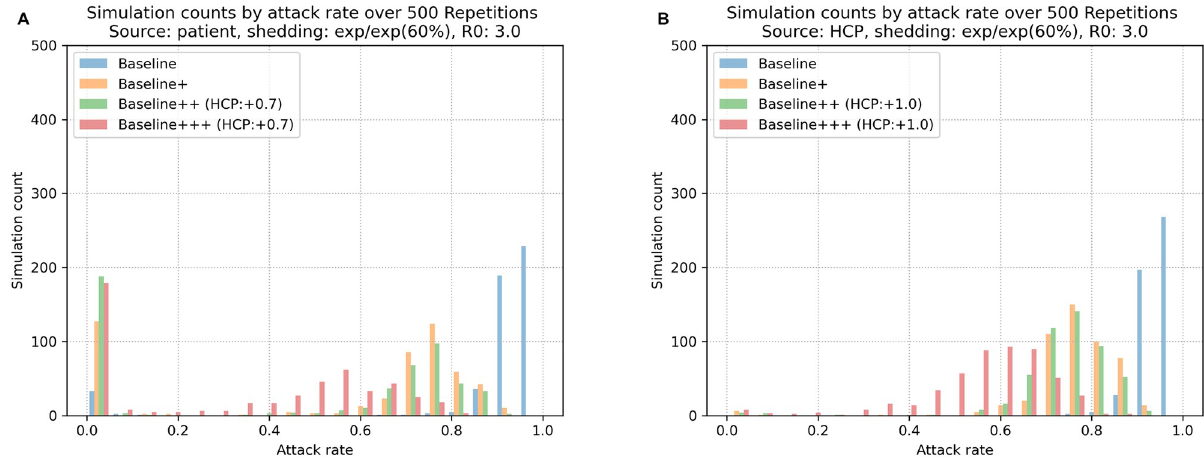
Fig 7. Frequency of replicates as a function of attack rates for different NPIs: (A) Scenario 1 and (B) Scenario 2. Each histogram displays the number of replicates (y axis; out of 500) with the specified overall attack rate. In Scenario 1, two peaks are commonly observed for each histogram; one where no transmission events occur (the infection is immediately quashed) and one indicating the fuller extent of an eventual outbreak. When no intervention is imposed (Baseline), only 31 simulations (6.2%) have no transmission events, while 83.6% (418) resulted in attack rates larger than 90%. In contrast, Baseline+++ and Baseline++ significantly increases the likelihood of observing no transmission events (162 and 175 simulations, 32.4% and 35.0%, respectively). In Scenario 2, even with interventions, infection is never quashed in any replicate. However, even in this scenario, there are no replicates with Baseline+++ interventions that have a near-100% attack rate. Furthermore, the frequency mass of the Baseline+++ intervention is substantially shifted to the left (towards lower attack rates) relative to the Baseline simulations.